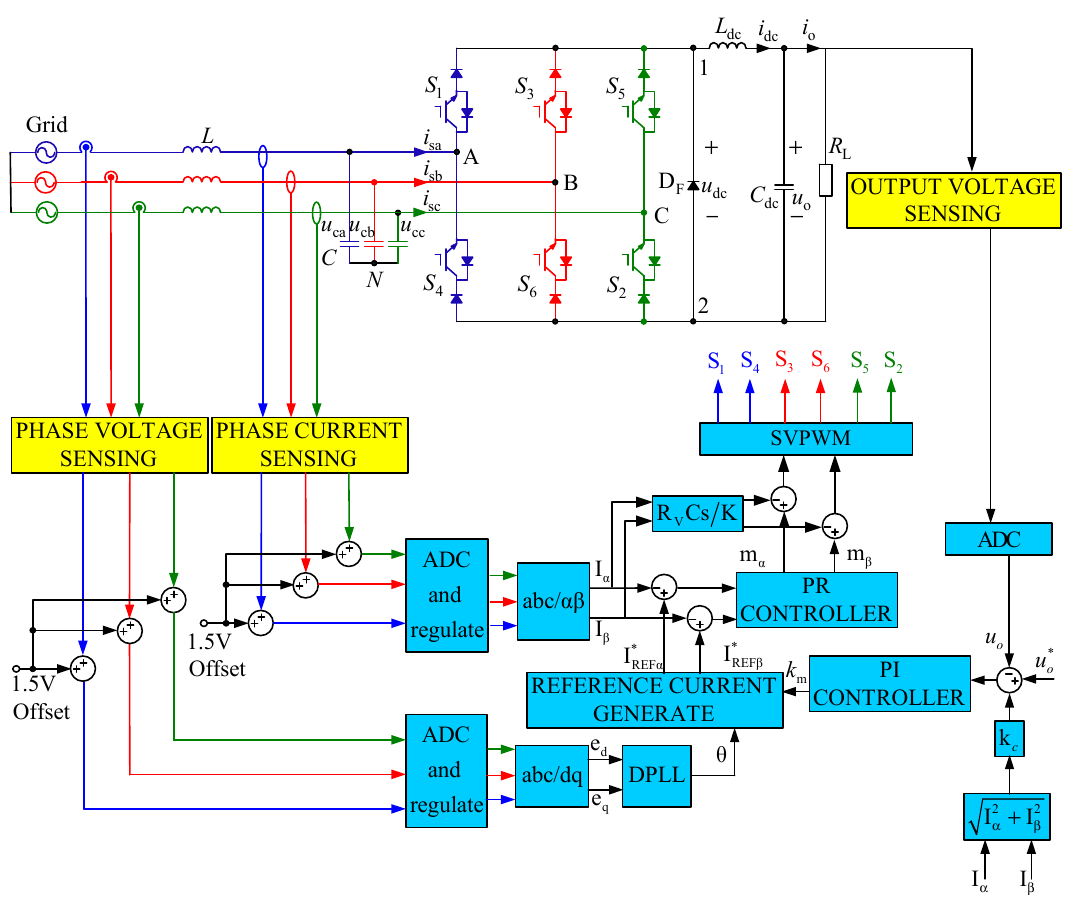
Figure 7. Circulating current suppression method of paralleled current source converters.